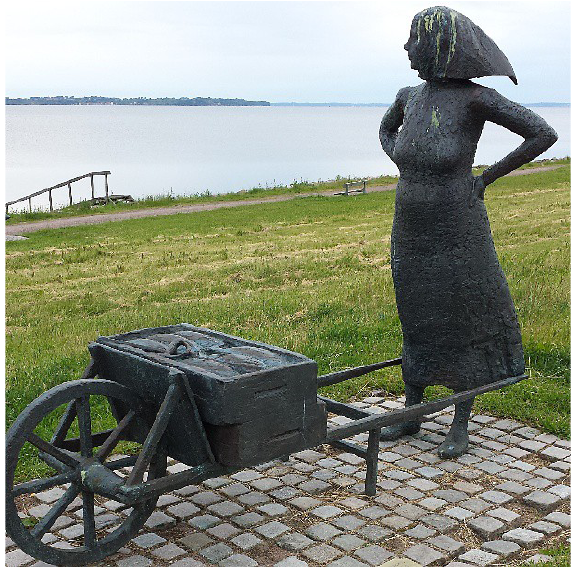
Figure 1. The photographer wants to show the attractive- ness of the city by using one of the most famous sculp- tures in the